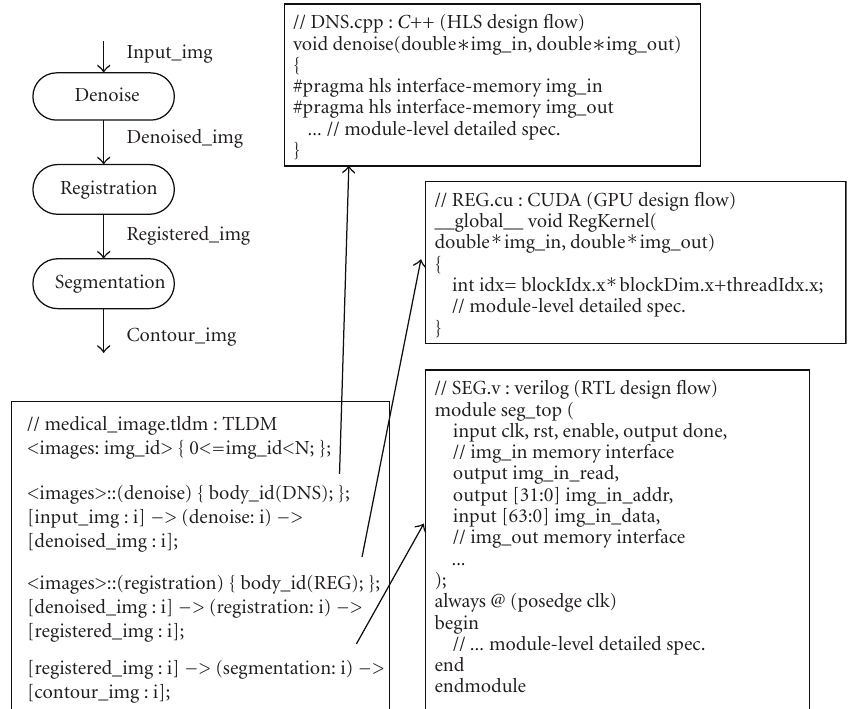
Figure 10: Heterogeneous computation integration using TLDM.